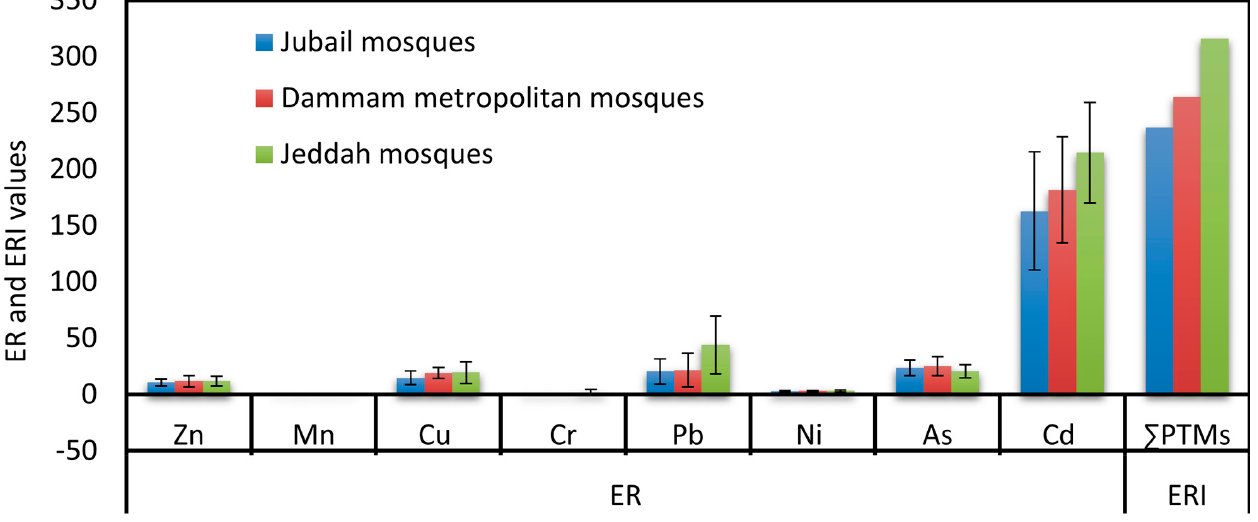
Figure 6. Variation of potential ecological risks for PHEs in ACFD of Jubail, Dammam metropolitan, and Jeddah mosques.